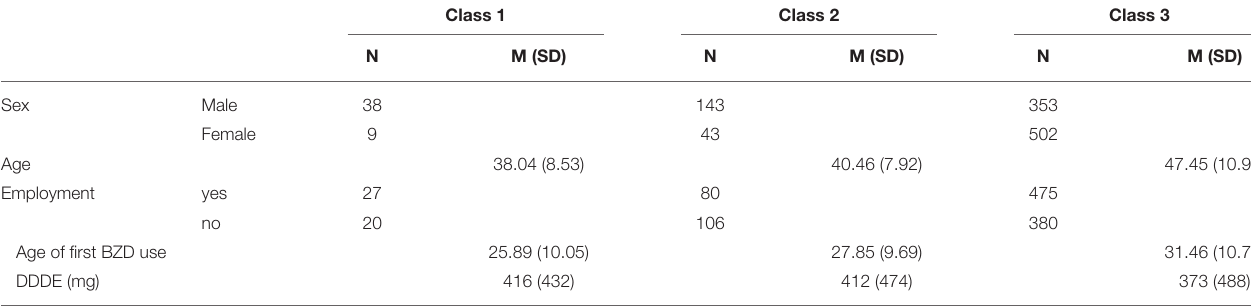
TABLE 3 | Characteristics of drugs used and socio-demographics, stratified by latent class.